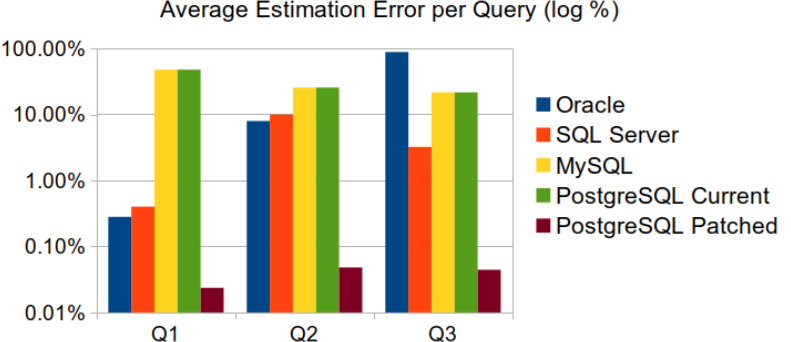
Figure 9. Comparison of join selectivity estimation errors of common DBMS and a patched version of PostgreSQL implementing the proposed